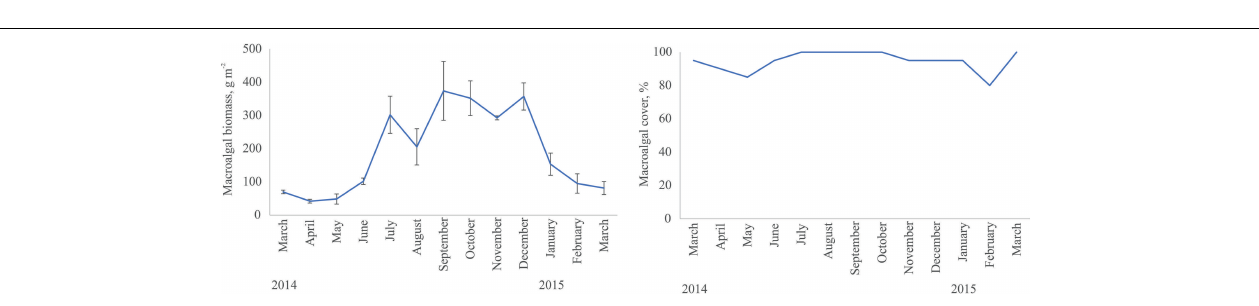
FIGURE 2 | Seasonal dynamics in the biomass and cover of C. aspera community in the study area (means ± Standard Error).